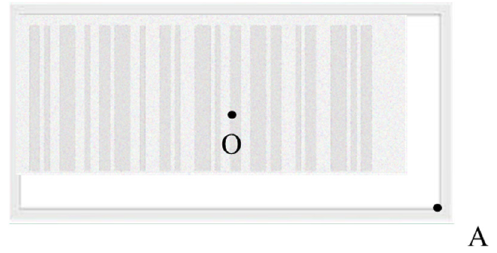
Figure 8. Ideal model of the adjusted graphic code.